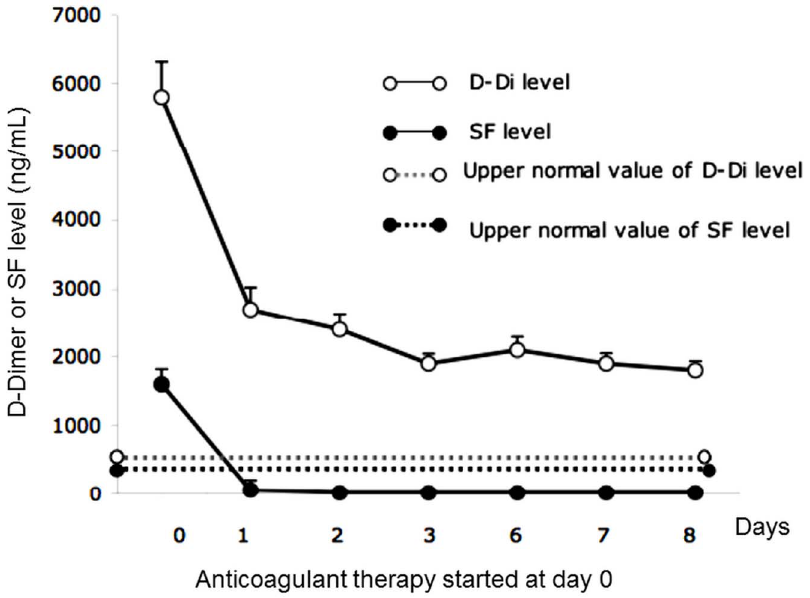
Figure 1. Evolution of SF and D-dimer levels in patients under anticoagulant therapy. SF and D-dimer (D-Di) concentrations were determined daily in patients before and after starting anticoagulant therapy.